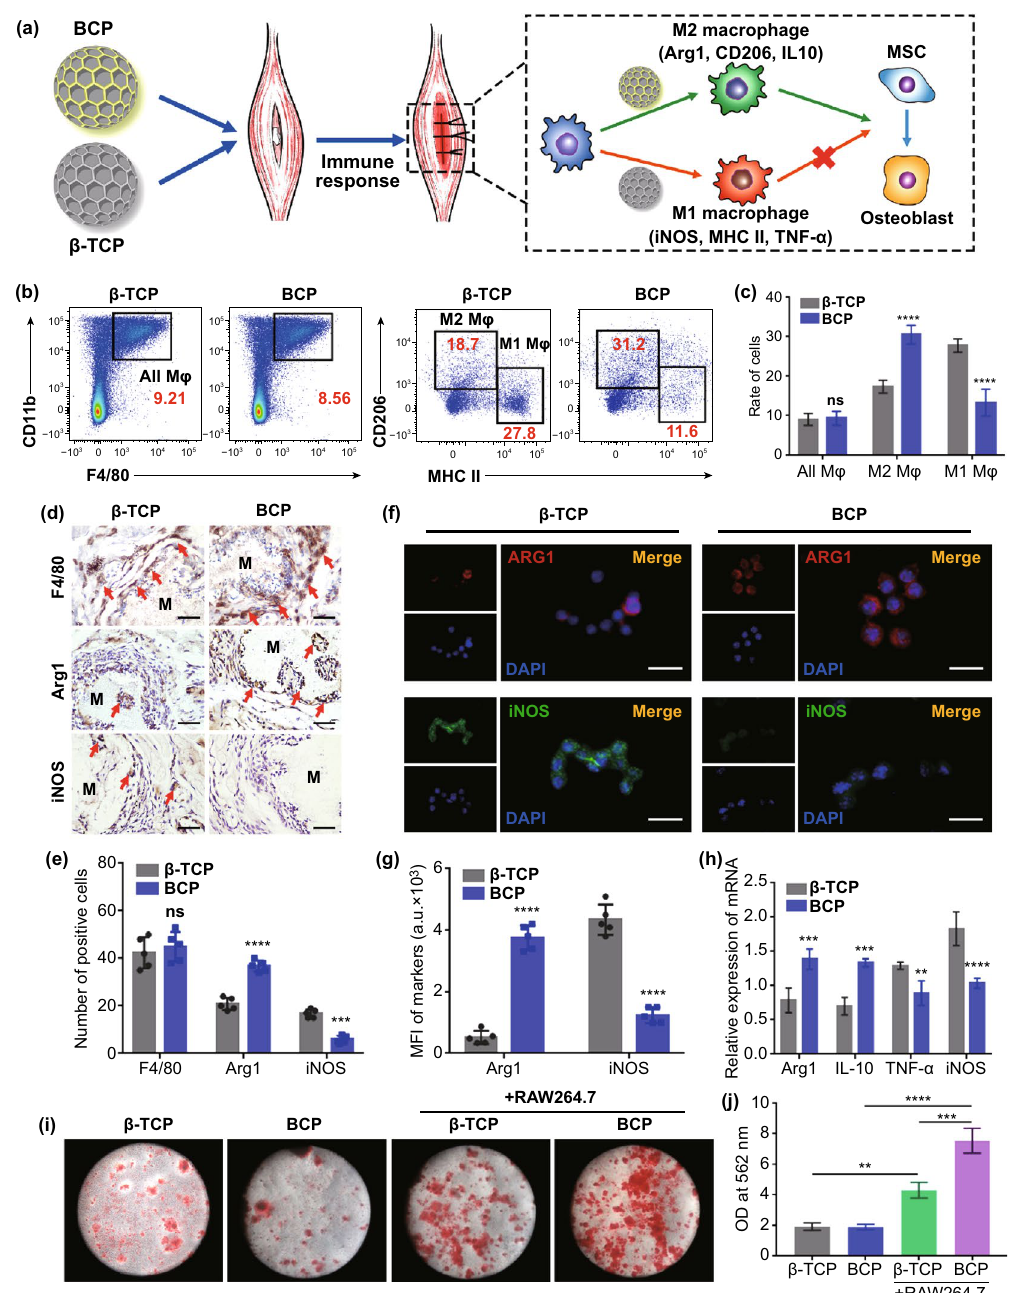
Fig. 2 a Schematic diagram of biomaterial-mediated macrophage polarization and MSC osteogenesis. b FACS of all macrophages (F4/80 + , CD11b +), M2 macrophages (F4/80 + , CD11b + , CD206 high , MHC II low ) and M1 macrophages (F4/80 + , CD11b + , CD206 low , MHC II high ) recruitment at 2 weeks after biomaterials implantation in vivo. c Semiquantification of gating strategy cells in (B). n = 6, **** P < 0.0001, ns: not significant. d IHC staining of F4/80—macrophage marker, Arg1—M2 macrophage marker and iNOS—M1 macrophage marker at 4 weeks after biomaterials implantation in vivo. Red arrow, positive cell. Scale bar = 100 μm. M, material. e Semiquantification of positively stained cells in ( d ). n = 5, *** P < 0.001, **** P < 0.0001, ns: not significant. f Immunofluorescent (IF) staining of Arg1 (red), iNOS (green) and nuclei (blue) after macrophages seeded on the BCP or β -TCP for 24 h. Scale bar = 5 μm. g Semiquantification of positively stained cells in ( f ). n = 5, **** P < 0.0001. h Relative mRNA expressions of macrophage polarization-related genes. M2 macrophage polarization-related